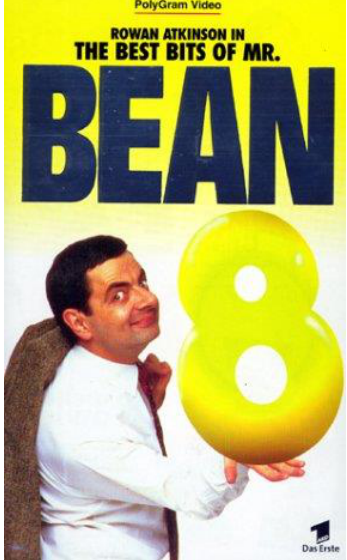
Figure 3. Sample image 3 and related API output.